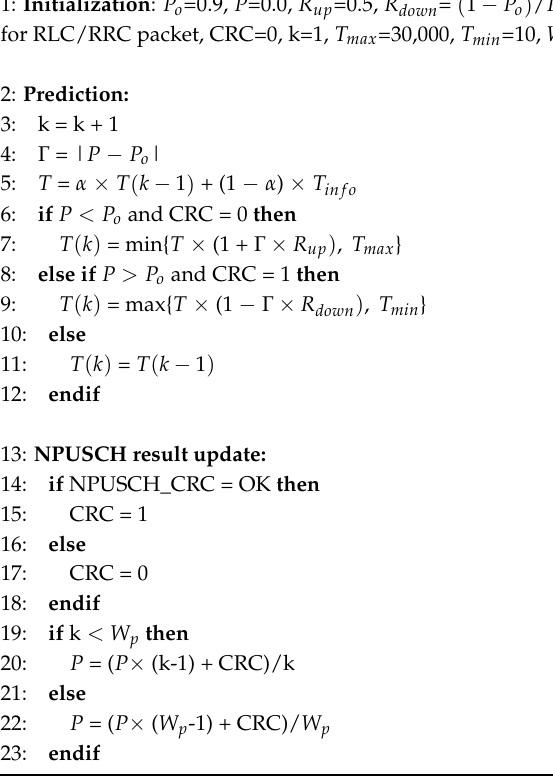
Algorithm 1. Proposed prediction algorithm for processing delay in an NB-IoT network